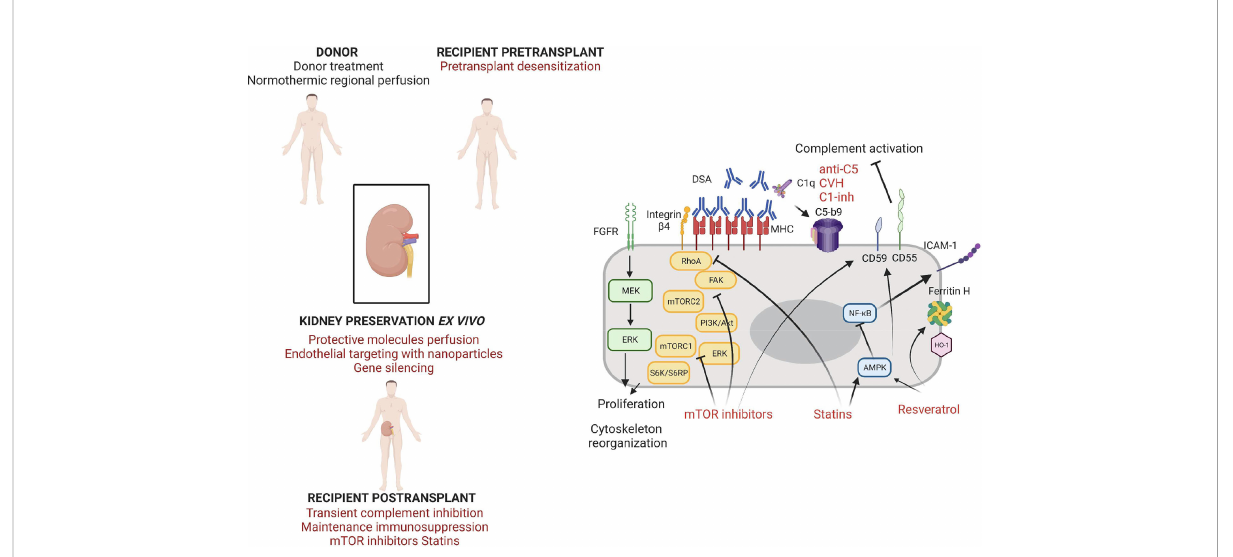
FIGURE 2 Strategies of endothelium protection in kidney